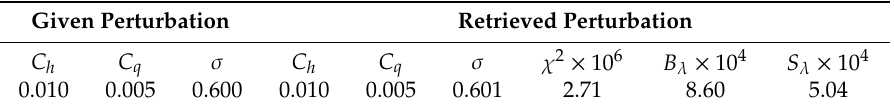
Table 2. Input spectral perturbations and output results using simple spectral scale parameters (i.e., C h (nm), C q (unitless), and spectral resolution in σ (nm)). The mean bias ( B λ ), root-mean-squared deviation ( S λ ), and cost function ( χ 2 ) of spectral fitting results are also shown.